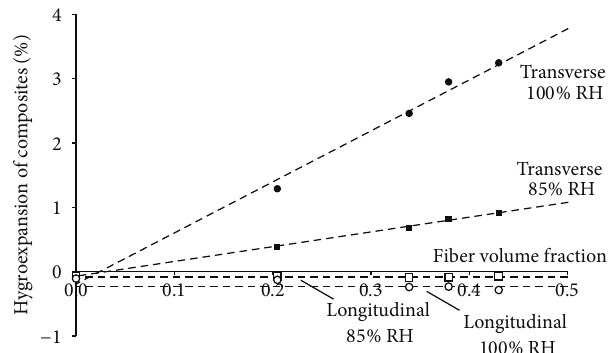
Figure 8: Hygroexpansion of unidirectional hemp fiber/pol- yethylene terephthalate composites as function of the fiber volume fraction. Hygroexpansion was measured in the longitudinal and transverse directions, and at the humidities of 85 and 100% RH, with respect to a reference humidity of 65% RH. Lines are calculated by micromechanical models. Modified from